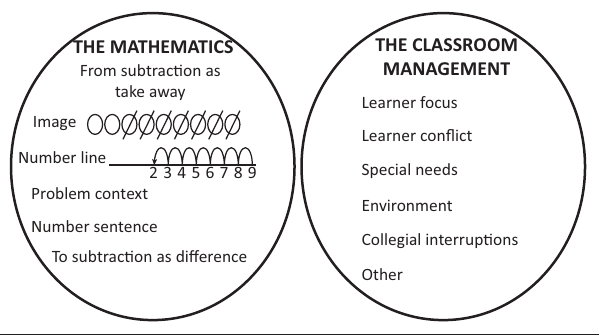
FIGURE 7: Separating the mathematics from the classroom